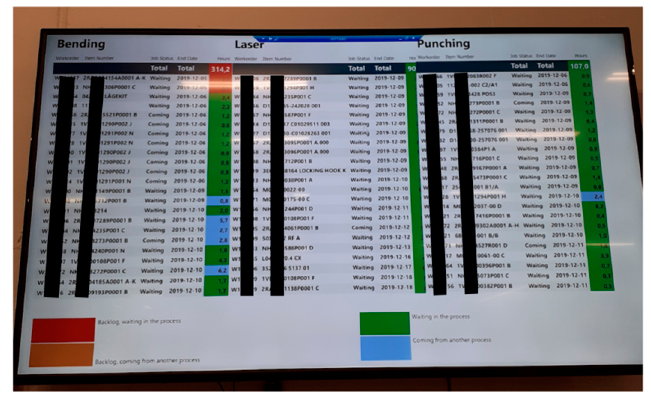
Figure 2. Work In Progress (WIP) displayed on Digital lean board. The digital lean board displaying the WIP and products awaiting to be processed has four different statuses and color codes for easy recognition in the display: (Red) Backlog, waiting in progress—the products have arrived at the department, but are allocated to the backlog, meaning that the products are behind schedule and are therefore marked as an urgent job.